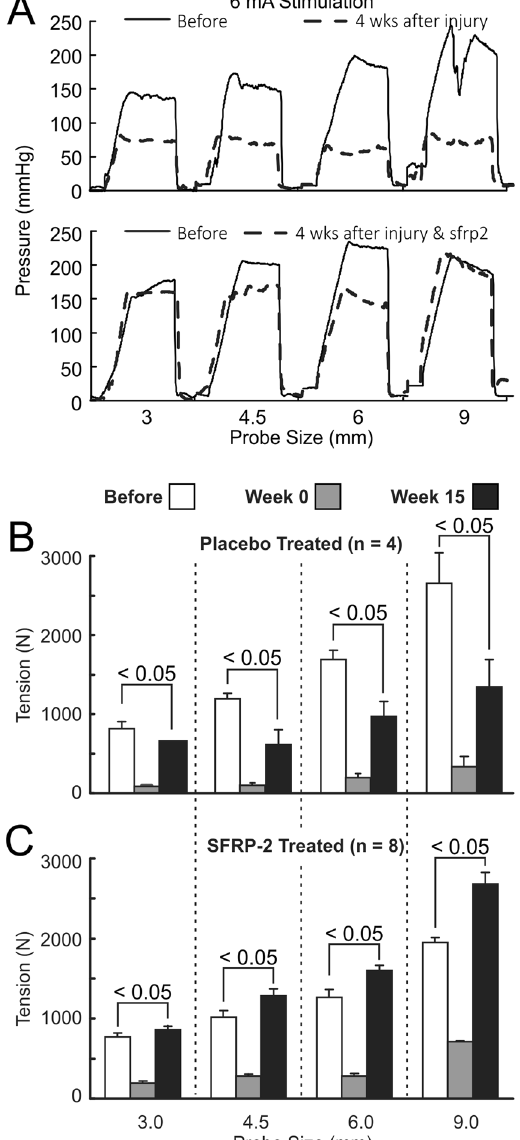
Figure 1. ( A ) Representative rabbit anal canal pressure tracings before and after EAS myotomy measured with probe sizes of 4.5, 6 and 9 mm diameter from animals treated with placebo (top panel) or Wnt antagonist (bottom panel) after 21 days post-treatment; ( B ) Effect of EAS myotomy on its length-tension relationship at 0 and 15 weeks post-myotomy. Muscle tension values from animals treated with placebo are shown. A significant decrease (P < 0.05) in EAS tension when compared to pre-injury values were observed for all probes in untreated animals. Panel (C) shows values from animals treated with a Wnt antagonist (sFRP-2; 2 µ g × 7 days). A significant improvement (p < 0.05) in EAS tension for probes 4.5, 6 and 9 mm was observed in sFRP-2 treated animals at 15 weeks post-myotomy compared to pre-myotomy